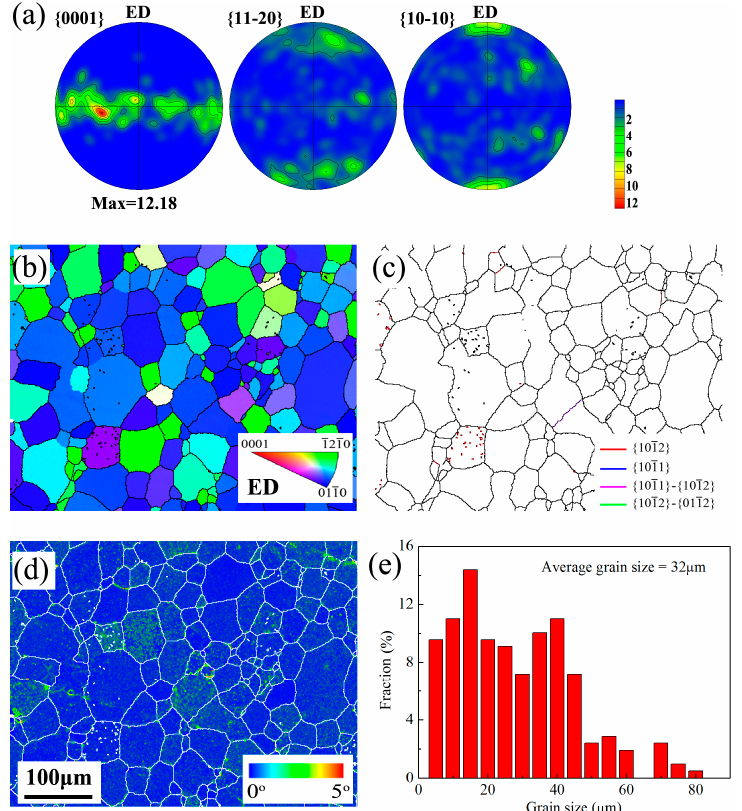
Figure 2. Microstructural characteristics of the as-solution AZ91 rod: ( a ) pole figures; ( b ) IPF map; ( c ) GB and TB map; ( d ) KAM map and ( e ) grain size distribution. The average grain size was calculated from the number fraction.